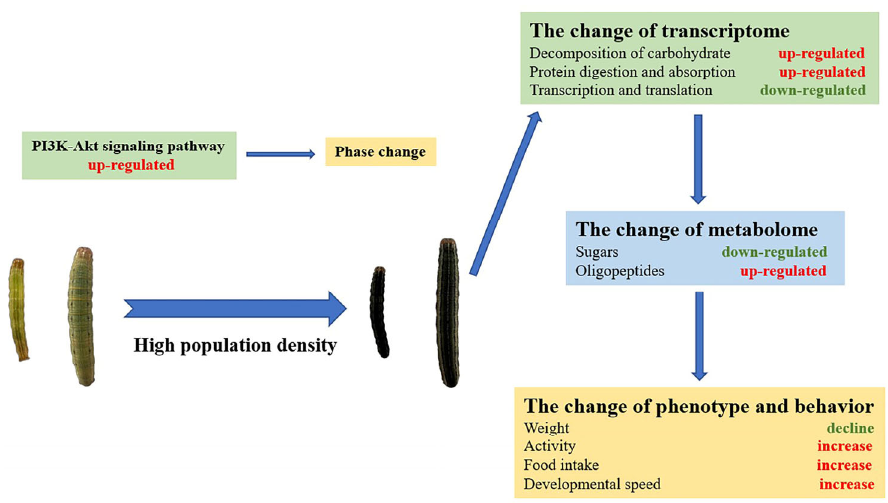
armyworms compared with solitary armyworms. DEGs and DAMs are marked in red and blue. Red indicates upregulation and blue downregulation.